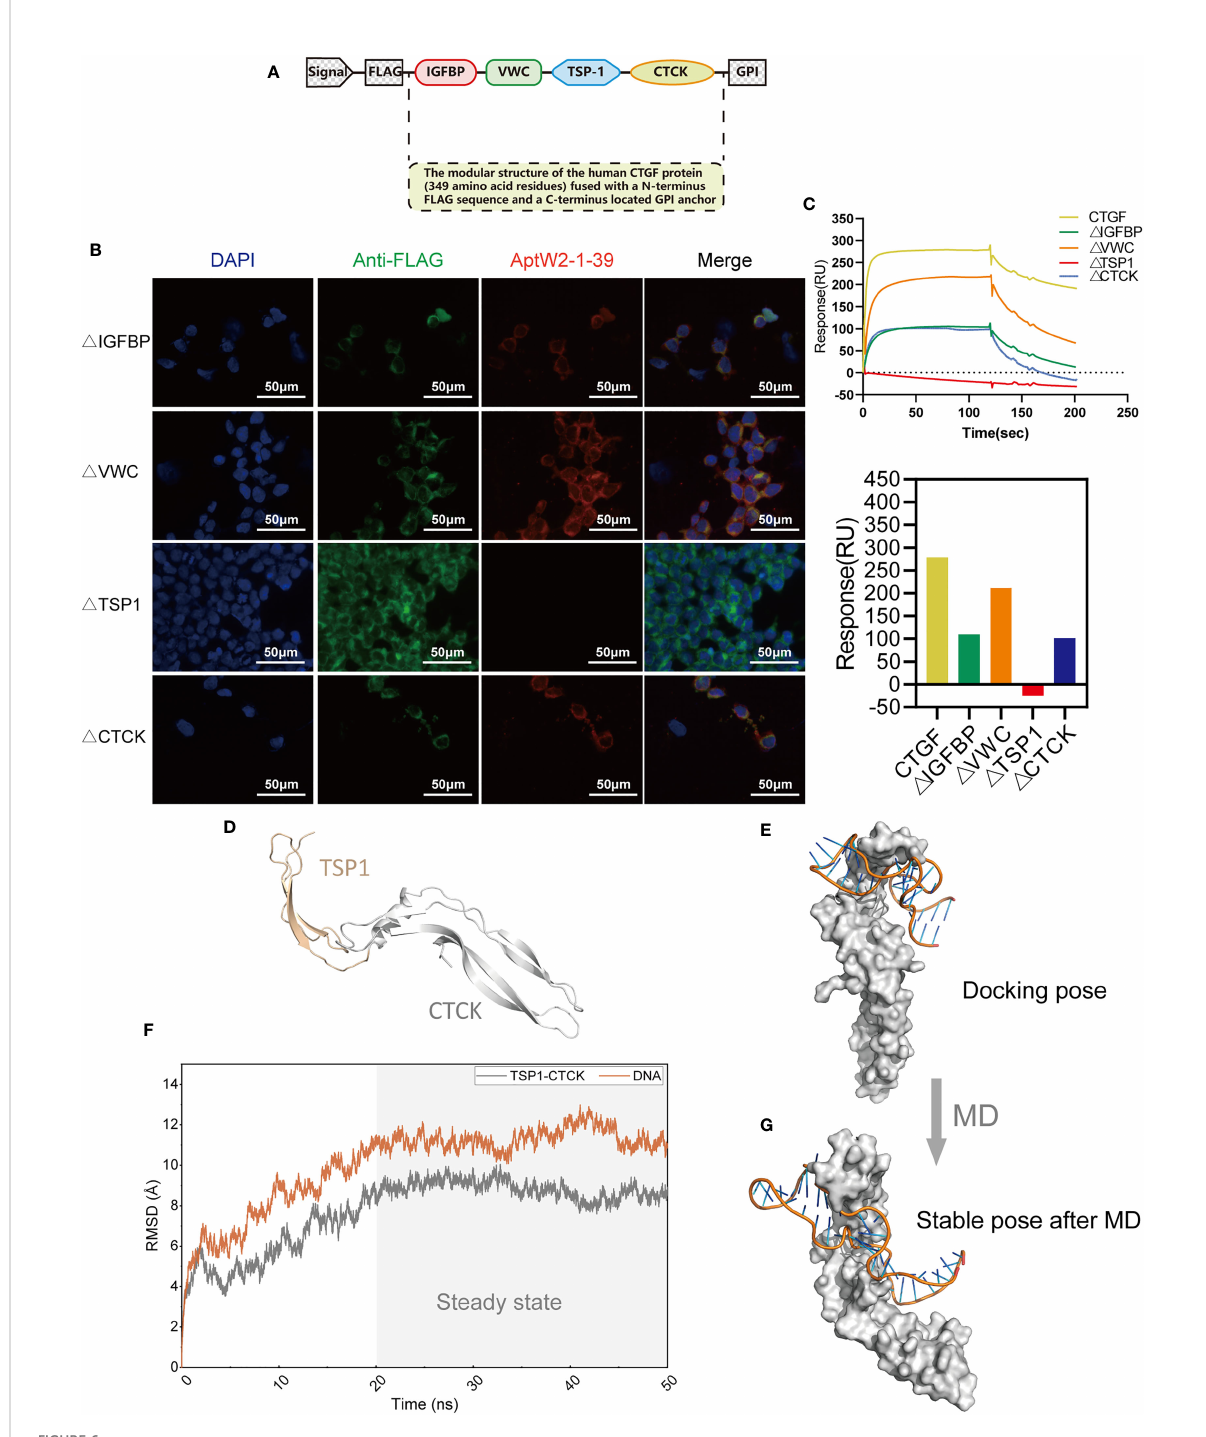
FIGURE 6 Identi fi cation of the binding domain of CTGF with AptW2-1-39-PEG. (A) The modular structure of human CTGF (349 amino acid residues) fused with an N-terminus FLAG sequence and a C-terminus located GPI anchor. (B) Immuno fl uorescence image of AptW2-1-39 and different deletion mutants of CTGF anchoring to HEK293T cells. The red color precisely indicates a Cy5-labeled AptW2-1-39-PEG. (C) SPR assay of AptW2-1-39-PEG targeting different deletion mutants of CTGF. (D) The TSP1-CTCK protein structure was predicted using homology modeling. (E) The TSP1-CTCK/AptW2-1-39 complex was predicted using molecule docking. (F) RMSD of the non-hydrogen atoms as a function of MD time. (G) The stable pose of the TSP1-CTCK/AptW2-1-39 complex after